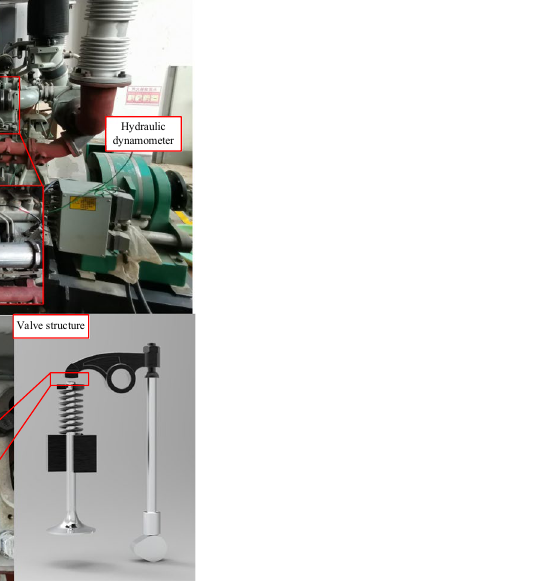
Figure 4. Layout of fault simulation test bench and